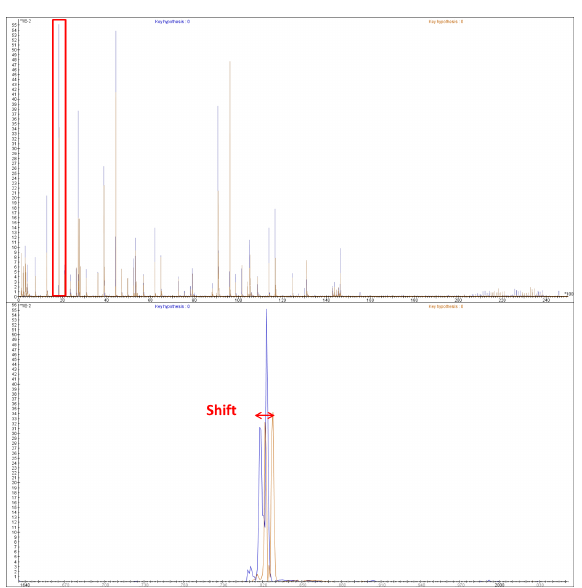
Figure 9: EM Campaign – SNR results on MMM initialization traces using seg on 2 different